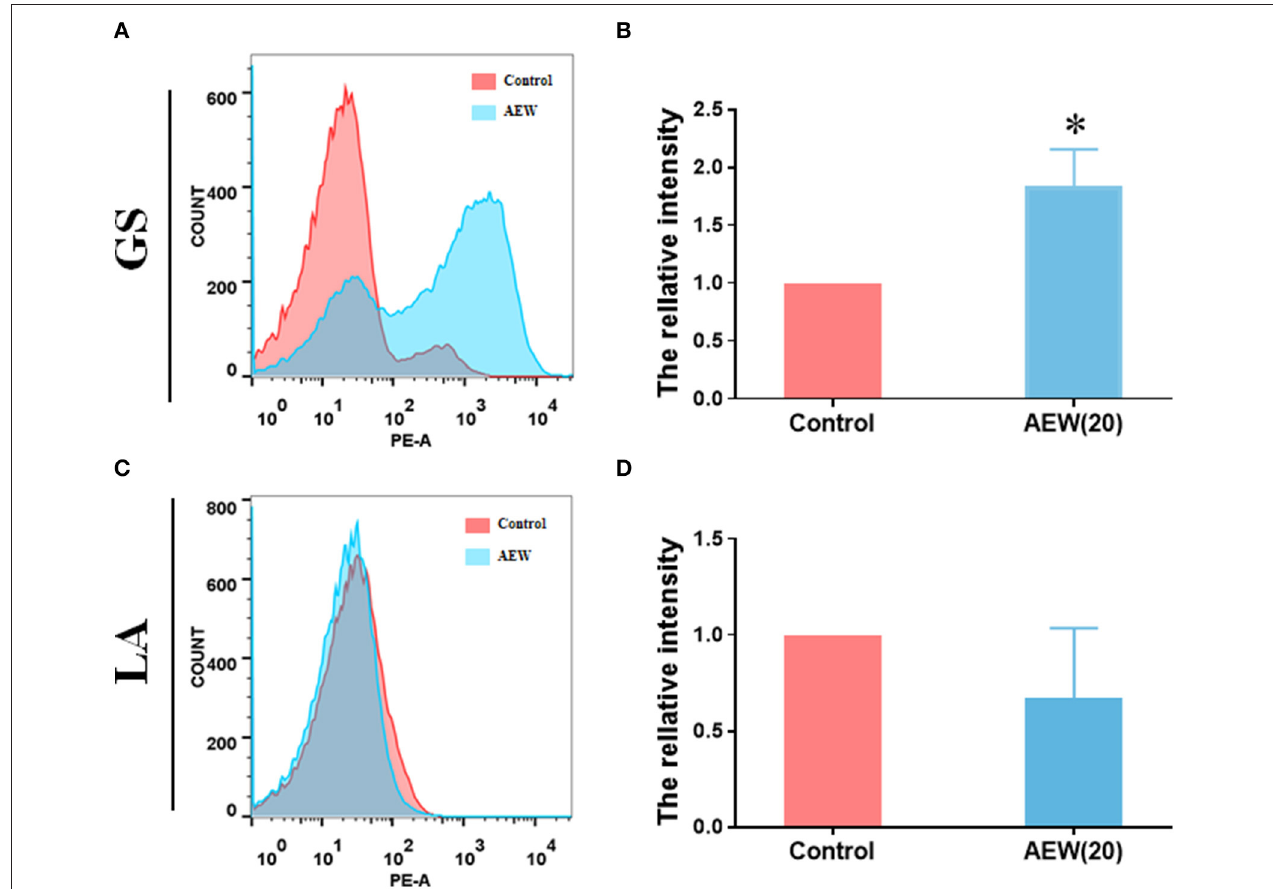
FIGURE 1 | Twenty ppm AEW increased the permeability of GS with less effect on LA. (A,C) Representative cell permeability data were observed by flow cytometry. (B,D) Statistics of relative PI fluorescence intensity of GS and LA were measured by flow cytometry ( n = 3, * p < 0.05 to control).